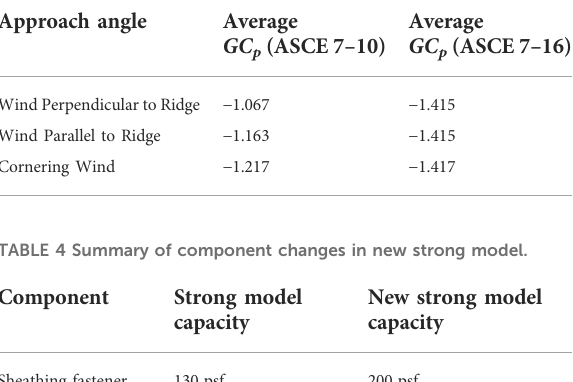
TABLE 3 Average GC p across roof usingmodi fi ed pressure zone maps.